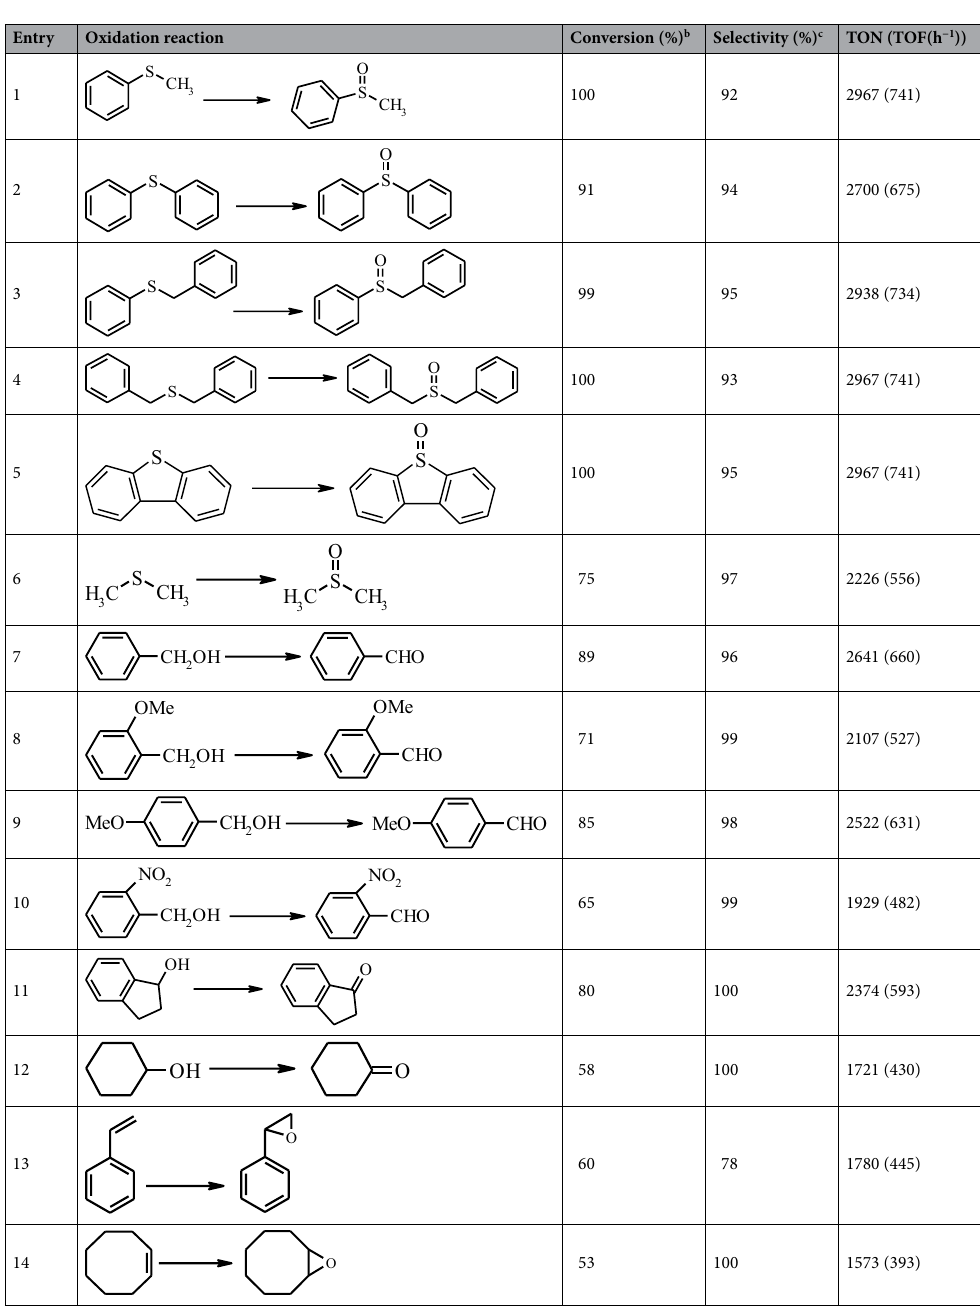
Table 2. Oxidation reactions catalyzed by 1 a . a Reaction conditions; four hours; catalyst (67.4 μM), H 2 O (1 mL), substrate (0.2 mmol), H 2 O 2 (0.4 mmol), at room temperature. b The GC conversion (%) is measured relative to the starting substrate. c Selectivity to sulfoxide = (sulfoxide %/ (sulfoxide% + sulfone%)) × 100; Selectivity to benzaldehyde = (aldehyde%/(aldehyde% + carboxylic acid%)) × 100; Selectivity to epoxide = (epoxide%/(epoxide% + aldehyde%)) × 100; TON = mol product/mol catalyst; TOF = TON/time of reaction (4